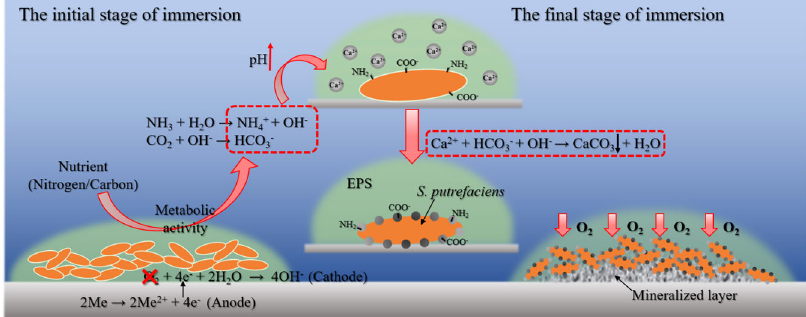
Fig. 10 Schematic illustration of the MICI mechanism via biomineralization induced by S. putrefaciens .